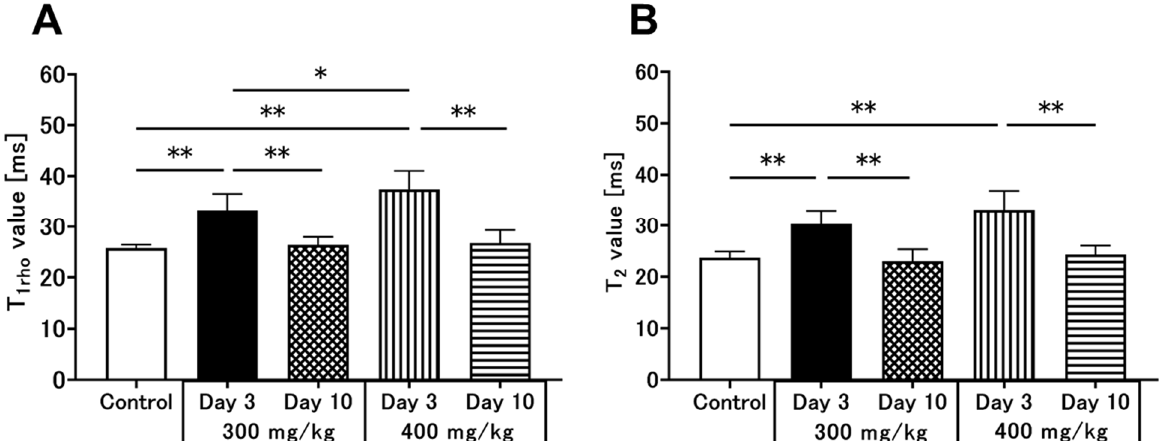
Figure 3. Changes in liver T 1 ρ ( A ) and T 2 ( B ) relaxation times in the high-dose (400 mg/kg) and low-dose (300 mg/kg) TAA groups compared to control. Data are presented as the mean ± standard deviation. Significance levels in comparison to control rats: * p < 0.05, ** p < 0.01. TAA, thioacetamide.